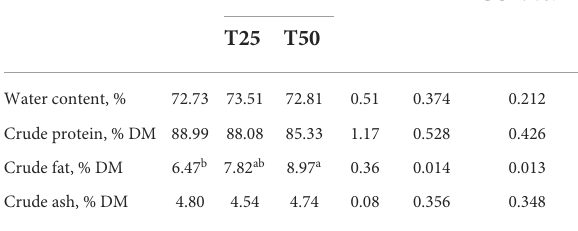
TABLE 6 Effects of FPR on the main nutrients of Simmental bull.